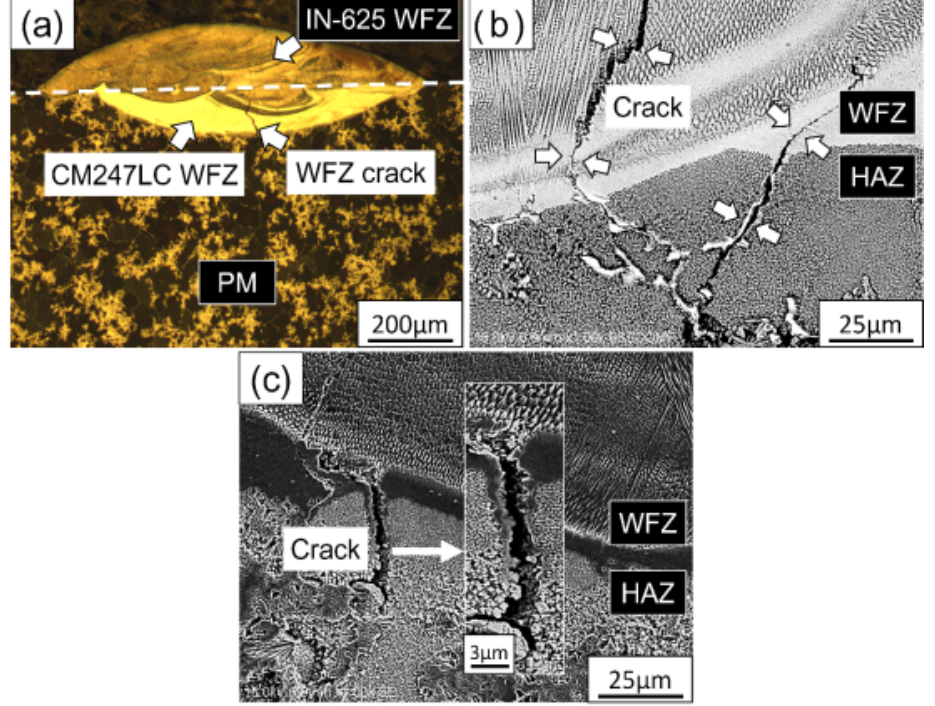
Figure 3. ( a ) IN ‐ 625 sealing on the top. Various cracks were still observed in ( b ) bottom of WFZ, or in ( c )